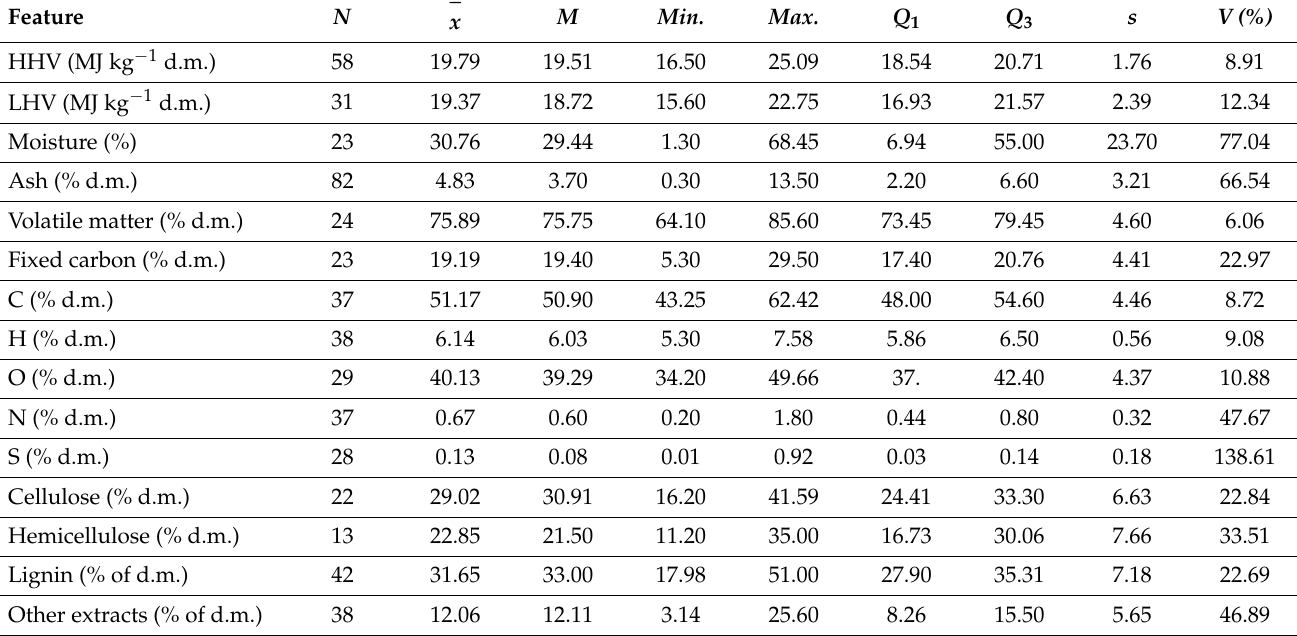
Table 9. Differentiation of thermophysical properties and elemental composition of deciduous